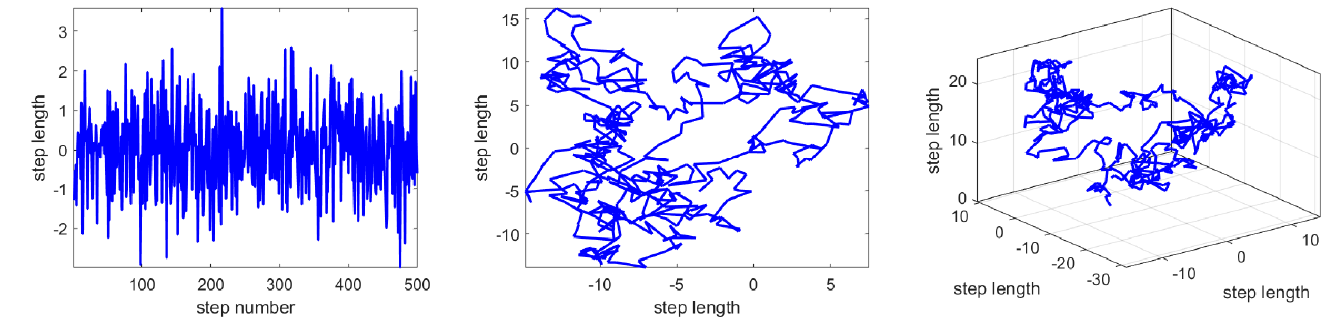
Figure 2. Brownian distribution, 2D Brownian trajectory, and 3D Brownian trajectory.